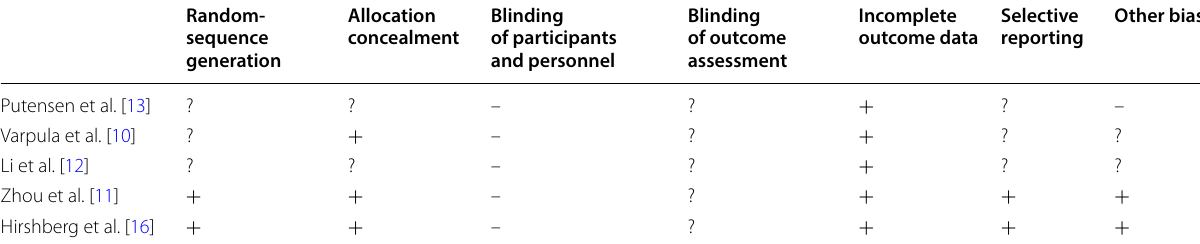
, low risk of bias; –, high risk of bias; ?, unclear risk +